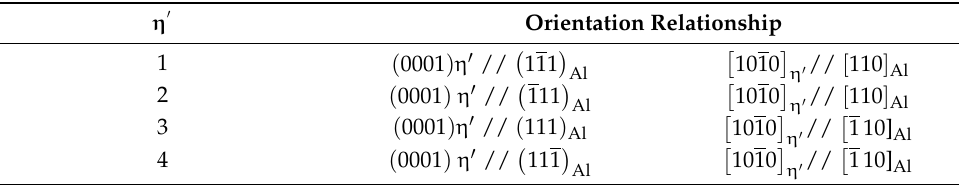
Table 1. Four variants of η (cid:48)